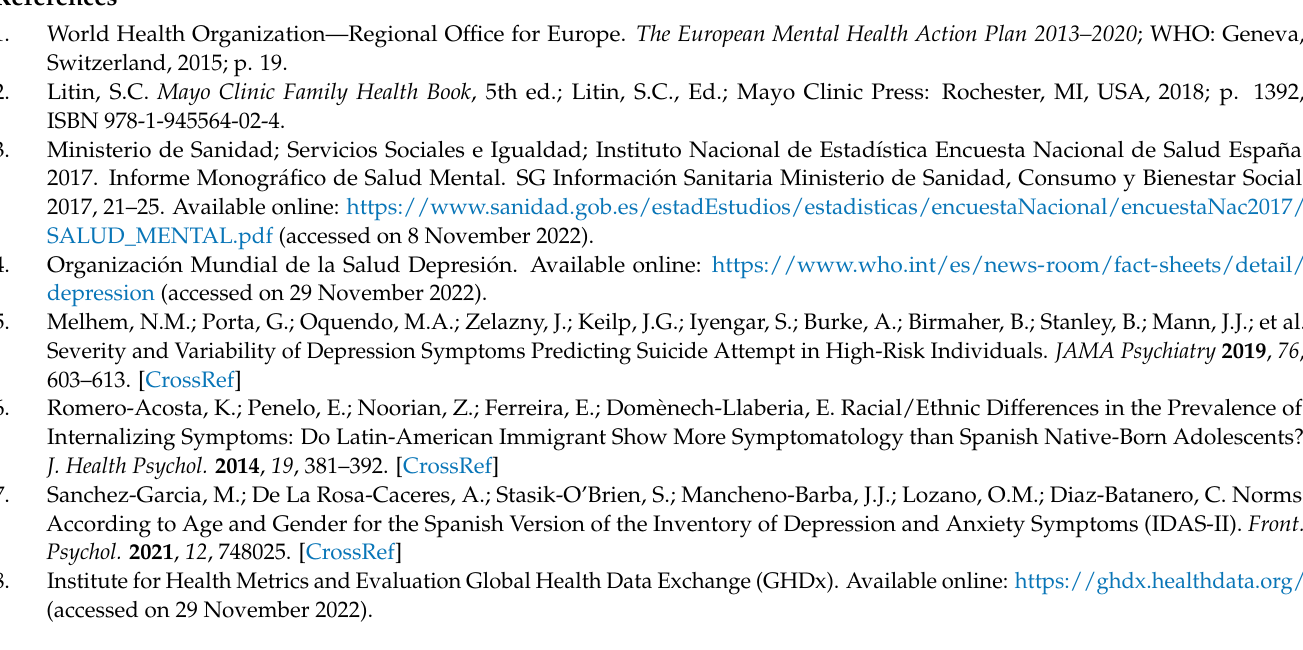
Table S4: Logarithmic binary regression model for depression, anxiety and antidepressants and anxiolytics use